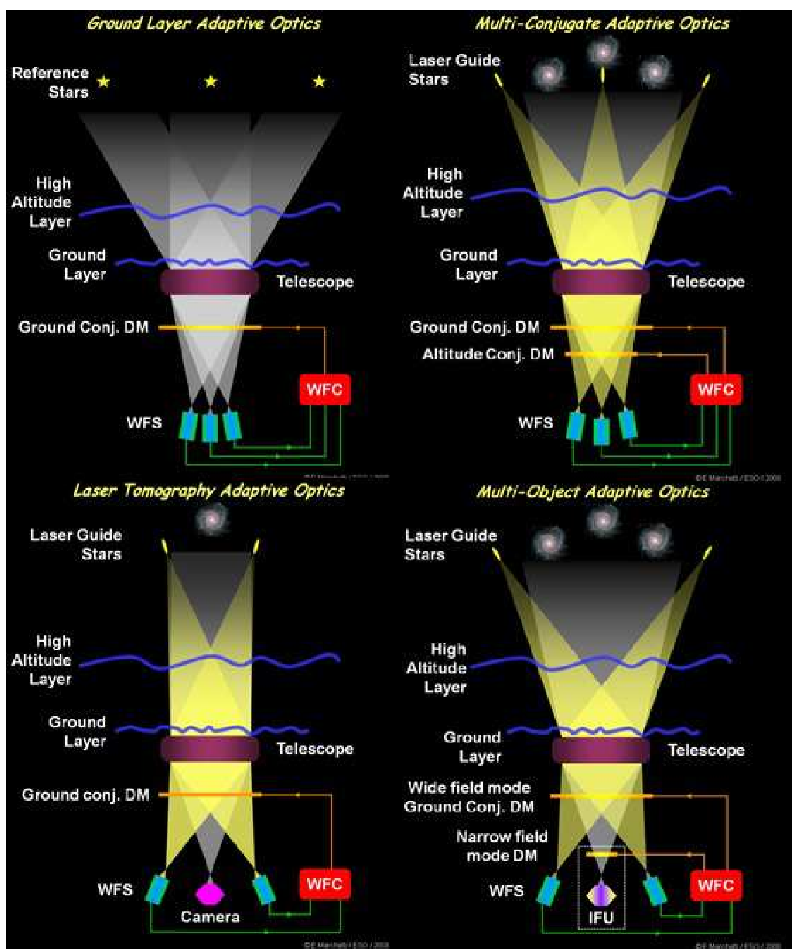
Figure 18. Conceptual illustrations of several AO techniques that aim to improve the sky coverage, Strehl ratio, or image quality of ground-based observations. Figure adapted from Davies and Kasper [266] with